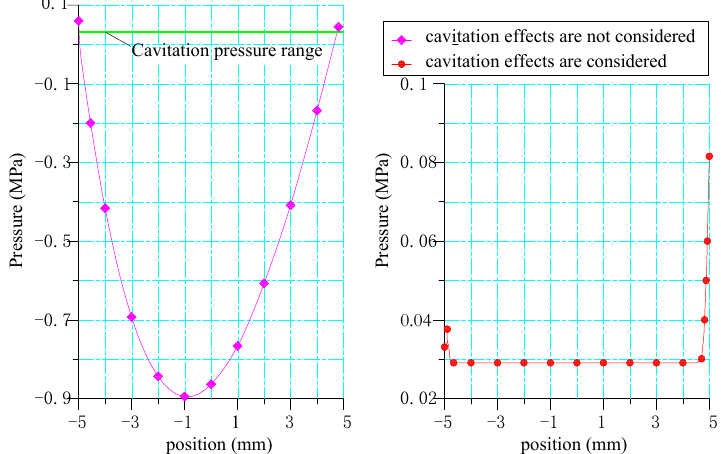
Figure 12. Pressure distribution on moving wall before and after considering cavitation effect in streamwise texture.